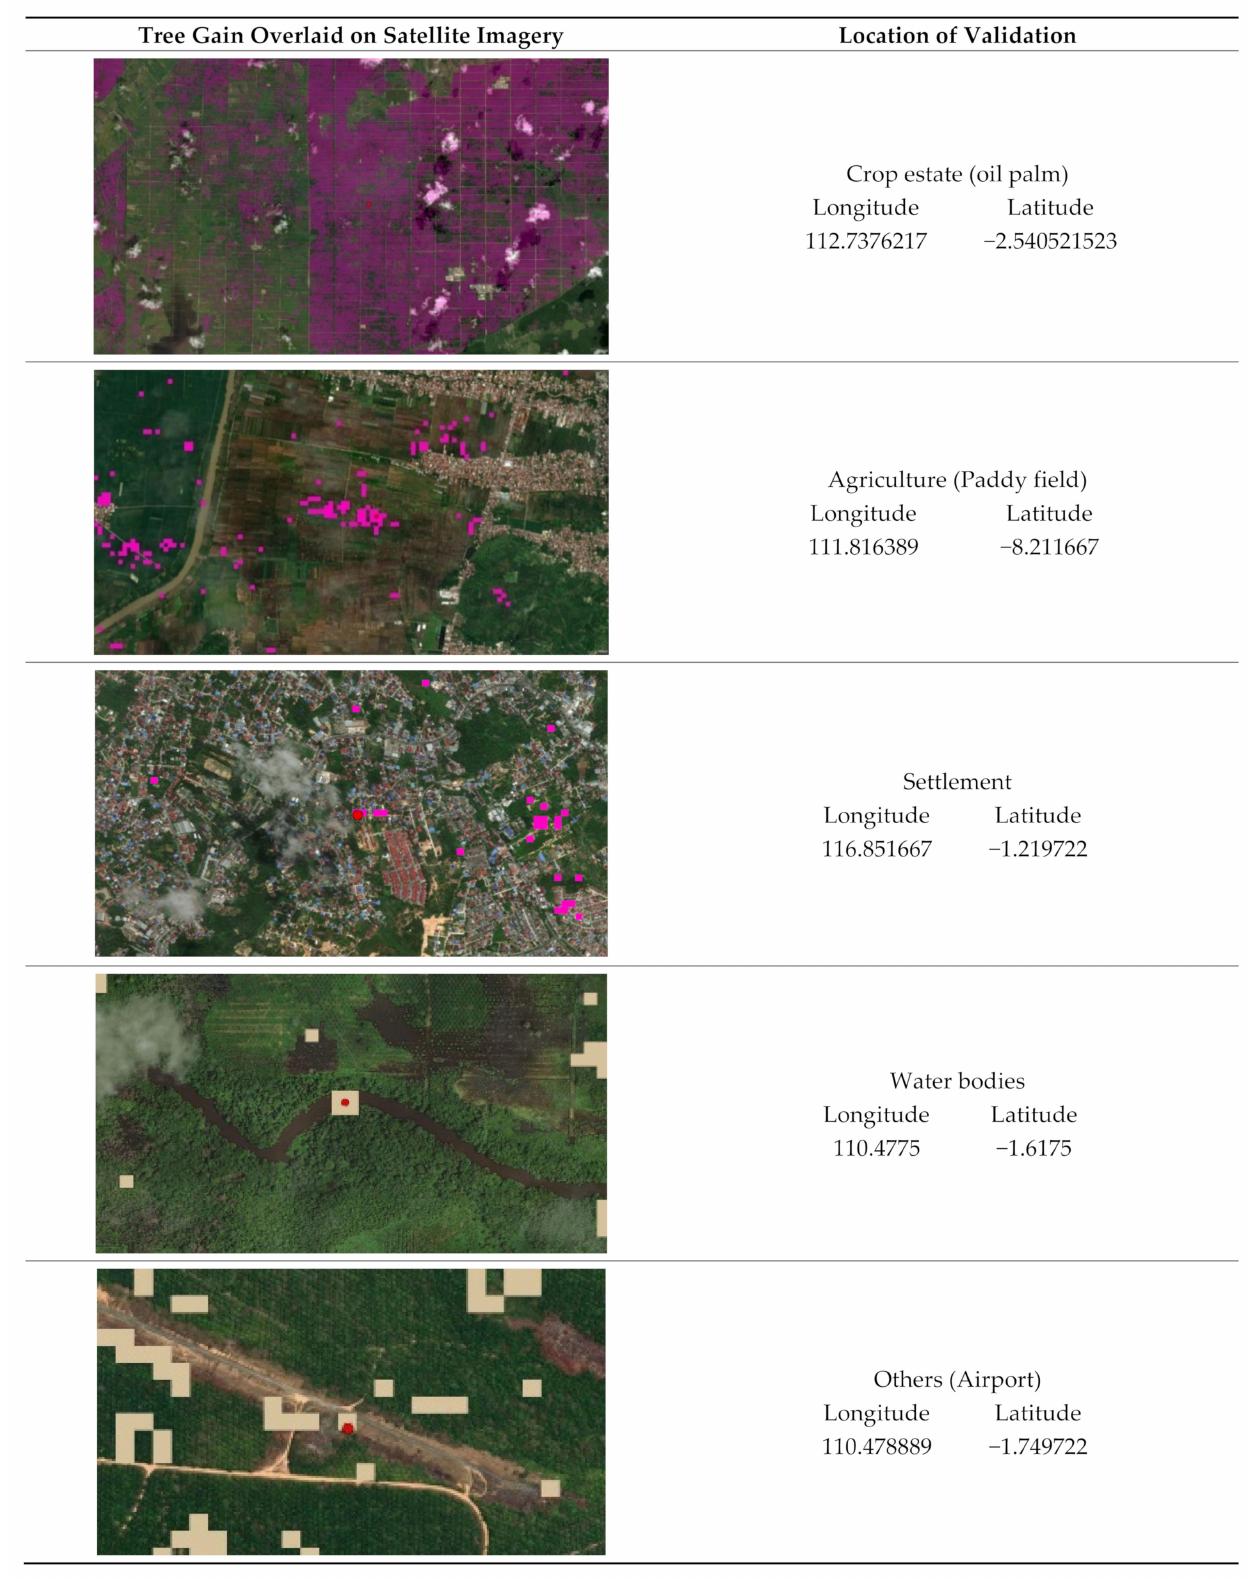
Figure 4. Example of validation process on the ineligible reforestation pixels (purple and pale brown color) from Hansen’s forest gain [17] using Landsat imagery with 30m spatial